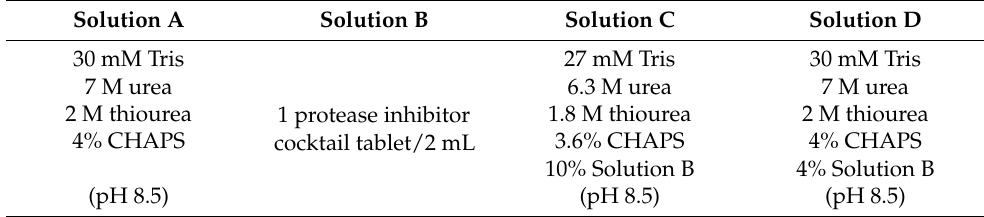
Table 1. Solutions used for the preparation of lysis buffer [15,20–30].